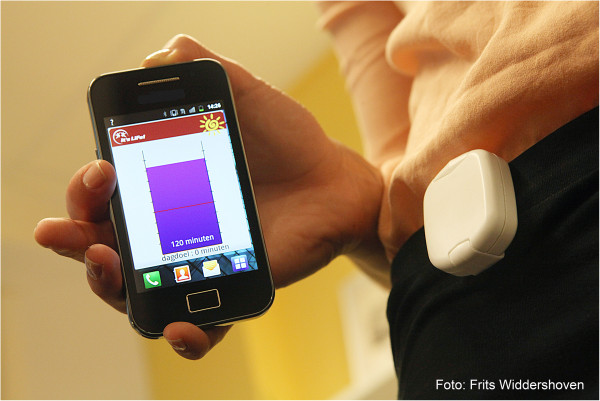
The
It’s LiFe!
tool.